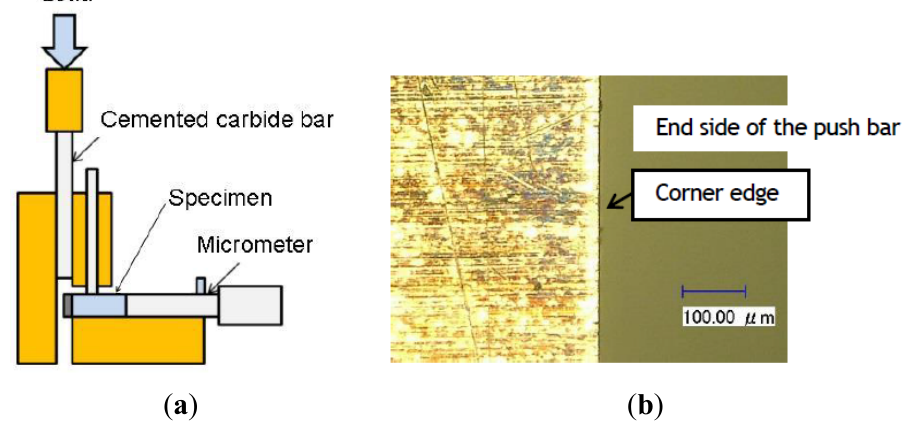
Figure 2. ( a ) Schematic diagram of the scraping shear-test apparatus as viewed from the side; ( b ) View of the edge of the push bar made of sintered WC-Co